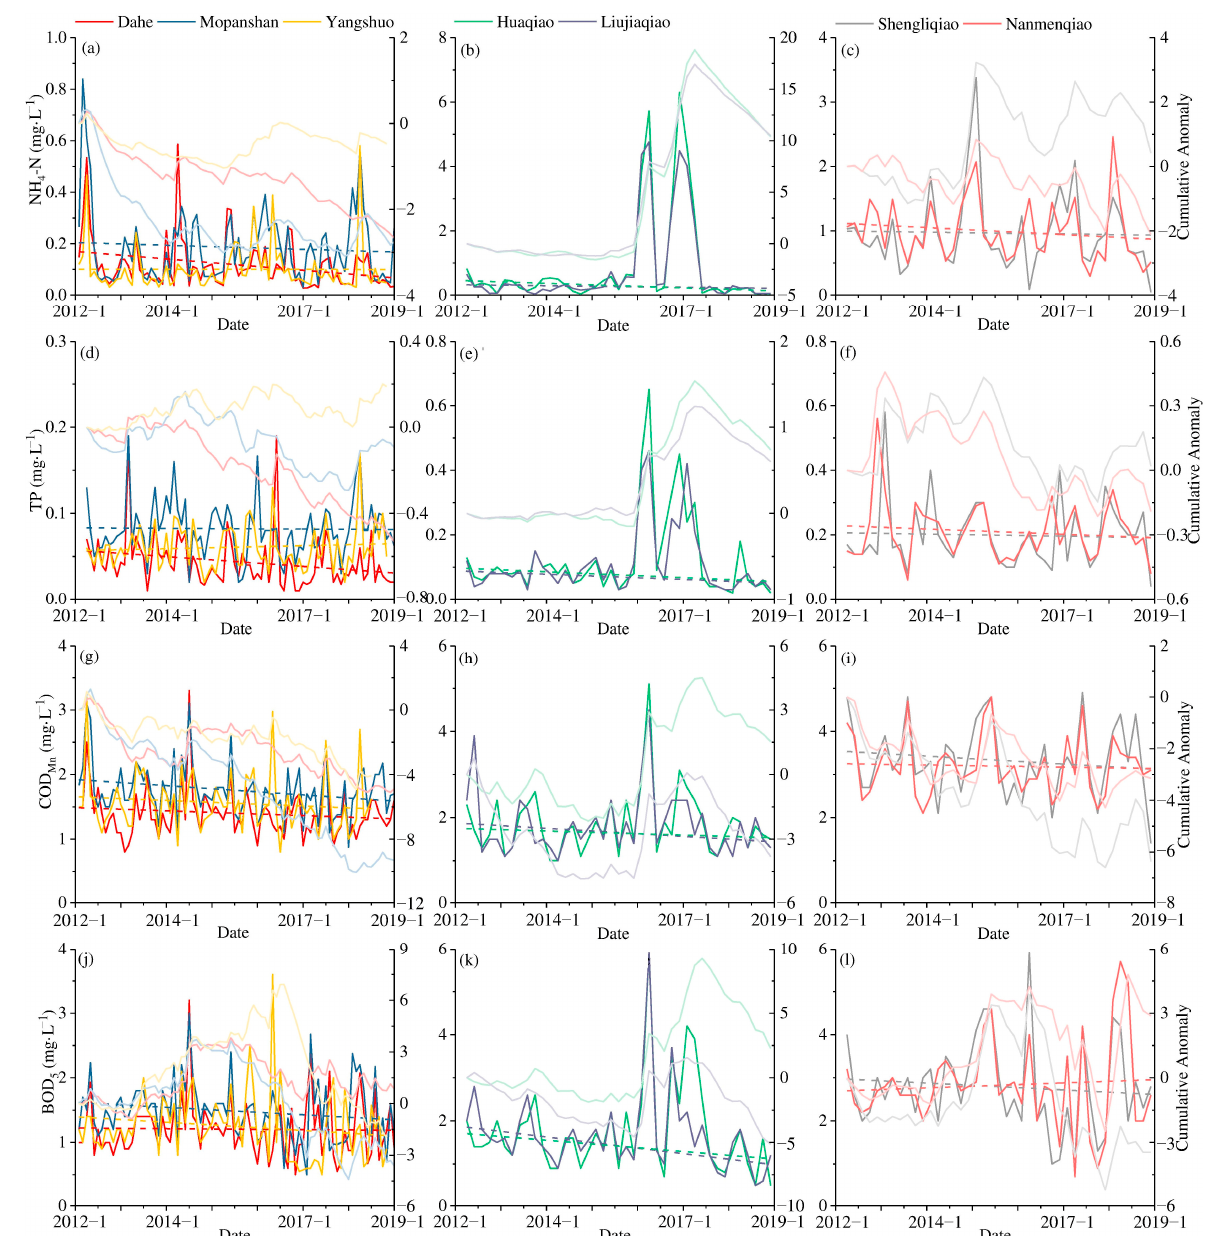
Figure 5. Changes in various water quality indicators at different stations in the LRB, ( a ) NH 4 -N of Lijiang River, ( b ) NH 4 -N of Xiaodong River, ( c ) NH 4 -N of Taohua River, ( d ) TP of Lijiang River, ( e ) TP of Xiaodong River, ( f ) TP of Taohua River, ( g ) COD Mn of Lijiang River, ( h ) COD Mn of Xiaodong River, ( i ) COD Mn of Taohua River, ( j ) BOD 5 of Lijiang River, ( k ) BOD 5 of Xiaodong River, and ( l ) BOD 5 of Taohua River.